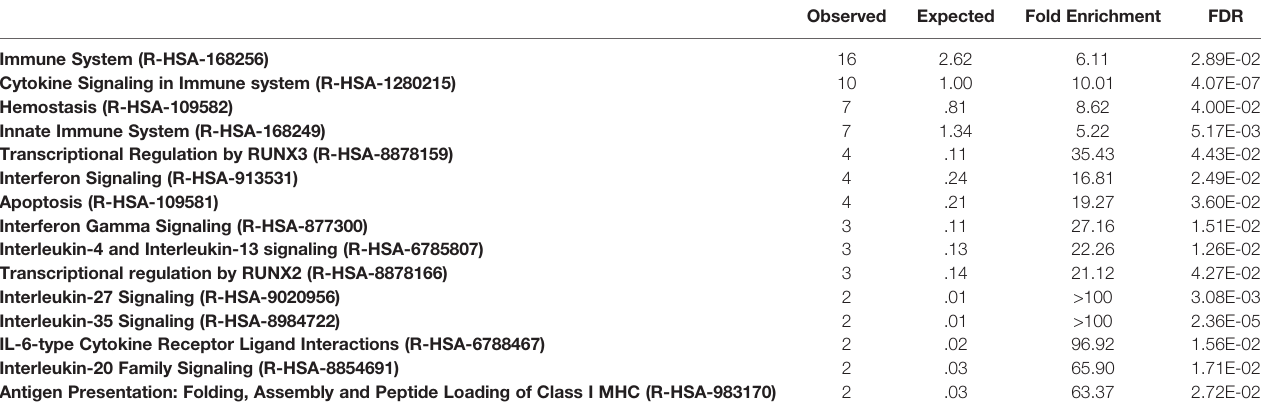
TABLE 2 | Reactome pathways overrepresentation against whole human